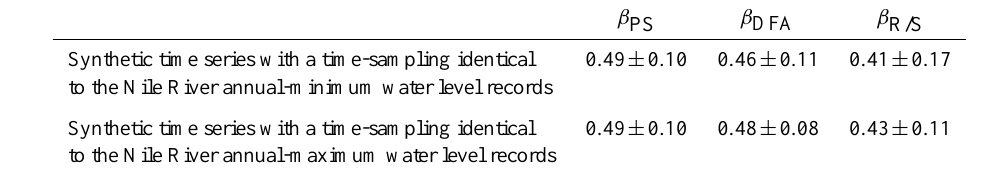
) are given in PS